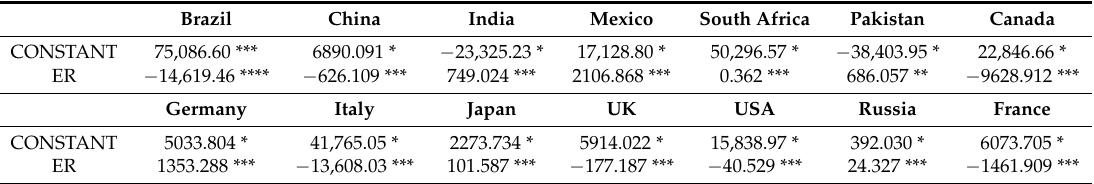
Table 1. Long-run estimates.